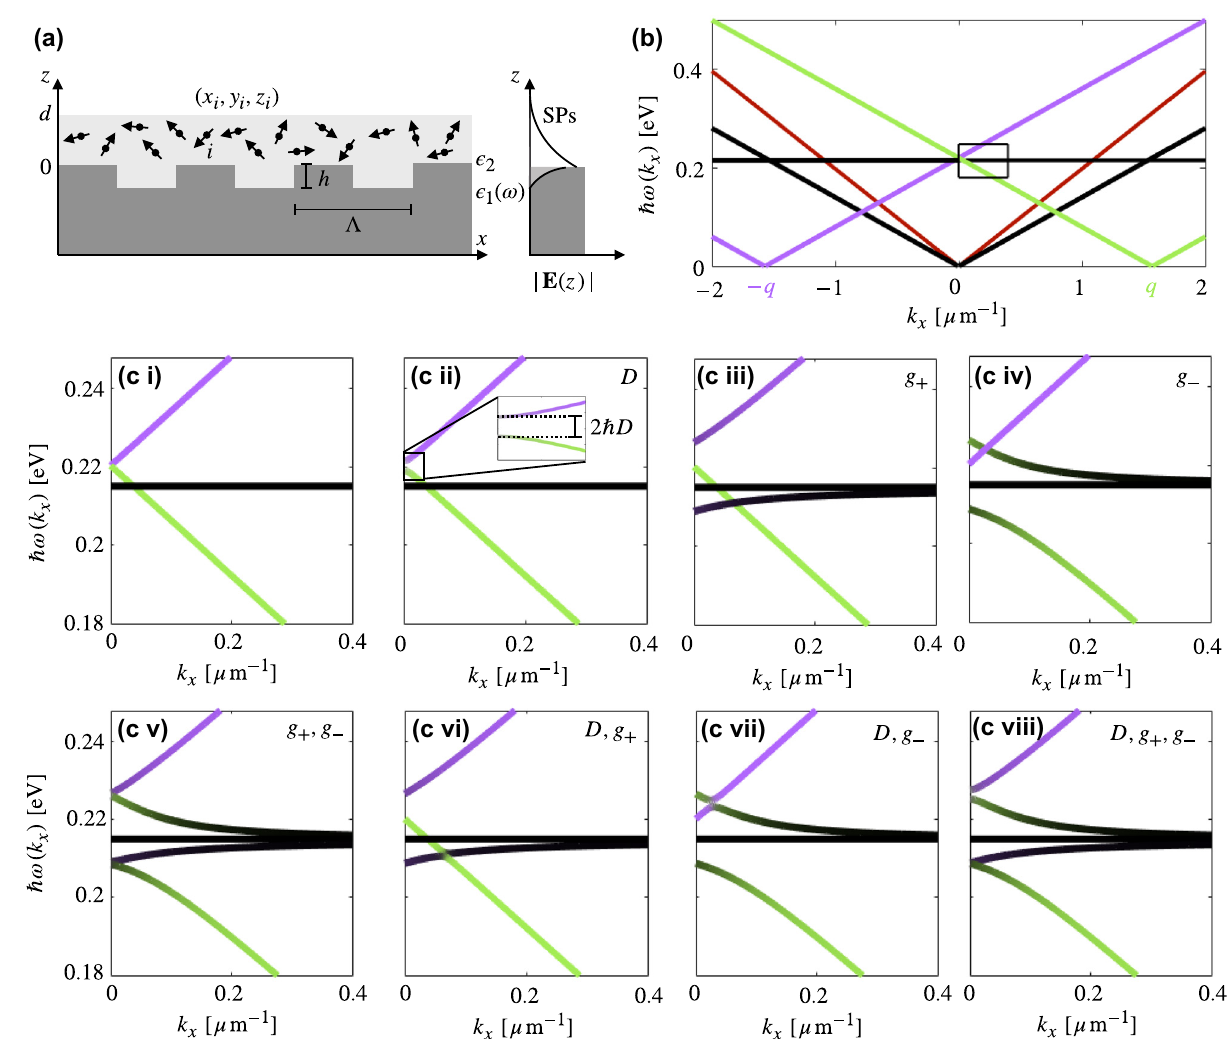
Figure 3: Strong coupling of molecules to a surface plasmon on a grating: (a) Schematic showing a slab of thickness d containing N randomly oriented and distributed dipoles, on a metal grating on which an SP can propagate. (b) The dispersion relation of the uncoupled 0 , ± 1 plasmon modes on a grating of period Λ = 4.0 μ m, and N degenerate molecular resonances. The air light-line is given in red. We take d = 0.9 μ m. (c (i)) Zoom-in of the relevant part of the uncoupled dispersion relation, and (c (ii–viii)) the contribution of each coupling individually and in combination, ending with the complete five-band dispersion relation in (c